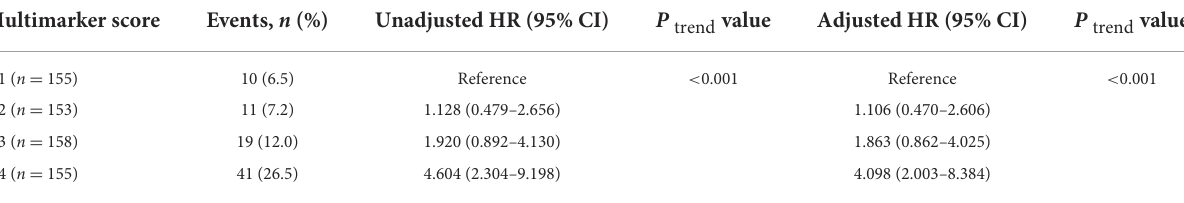
TABLE 5 Multivariable-adjusted HRs (95% CI) of MACE according to quartiles of multimarker scores among ACS patients.